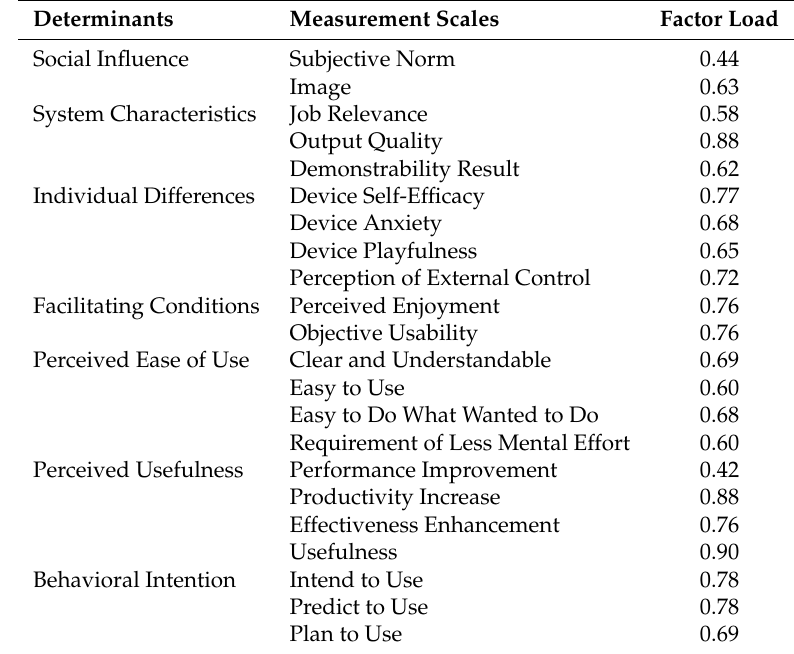
Table 4. The standardization factor load of each measurement